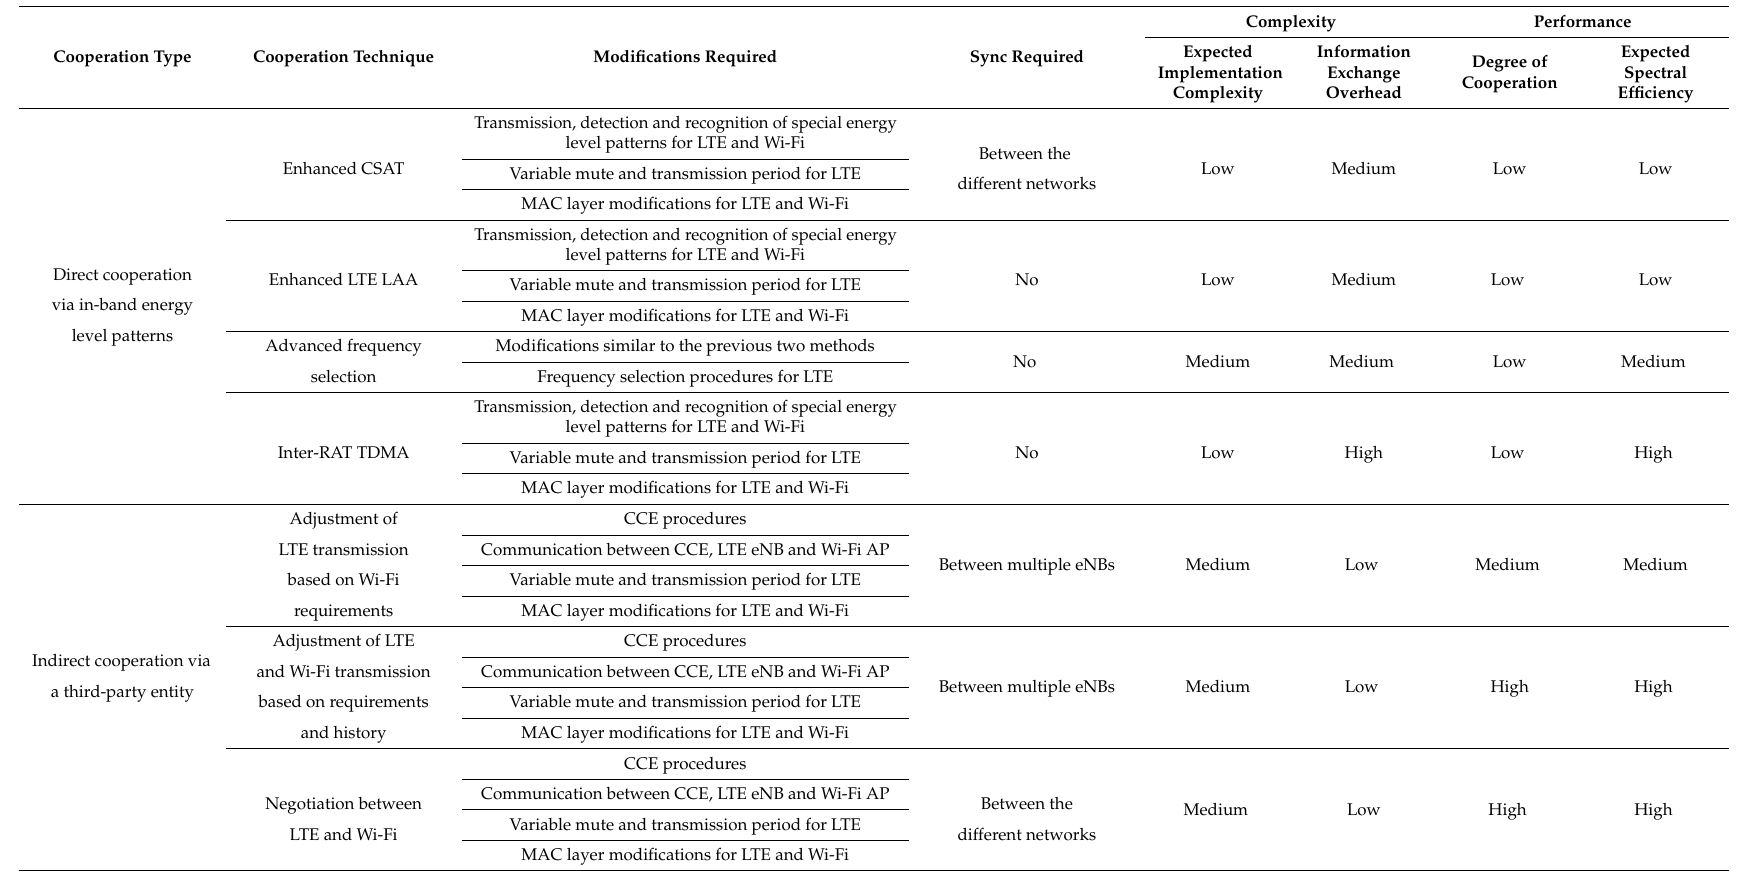
Table 3. Comparison of the different proposed cooperation